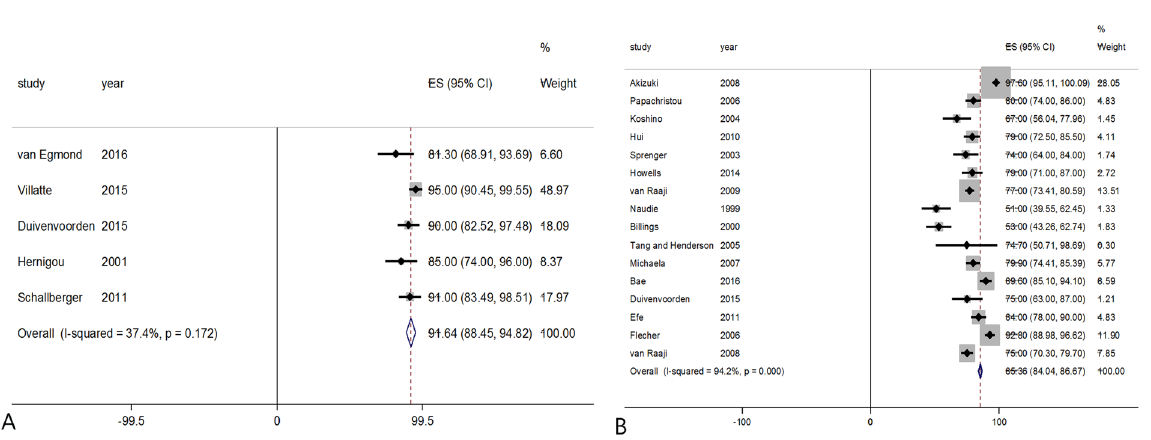
Figure 4. Forest plot showing the pooled 10-year survival rates of open wedge ( A ) and closed wedge ( B ) high tibial